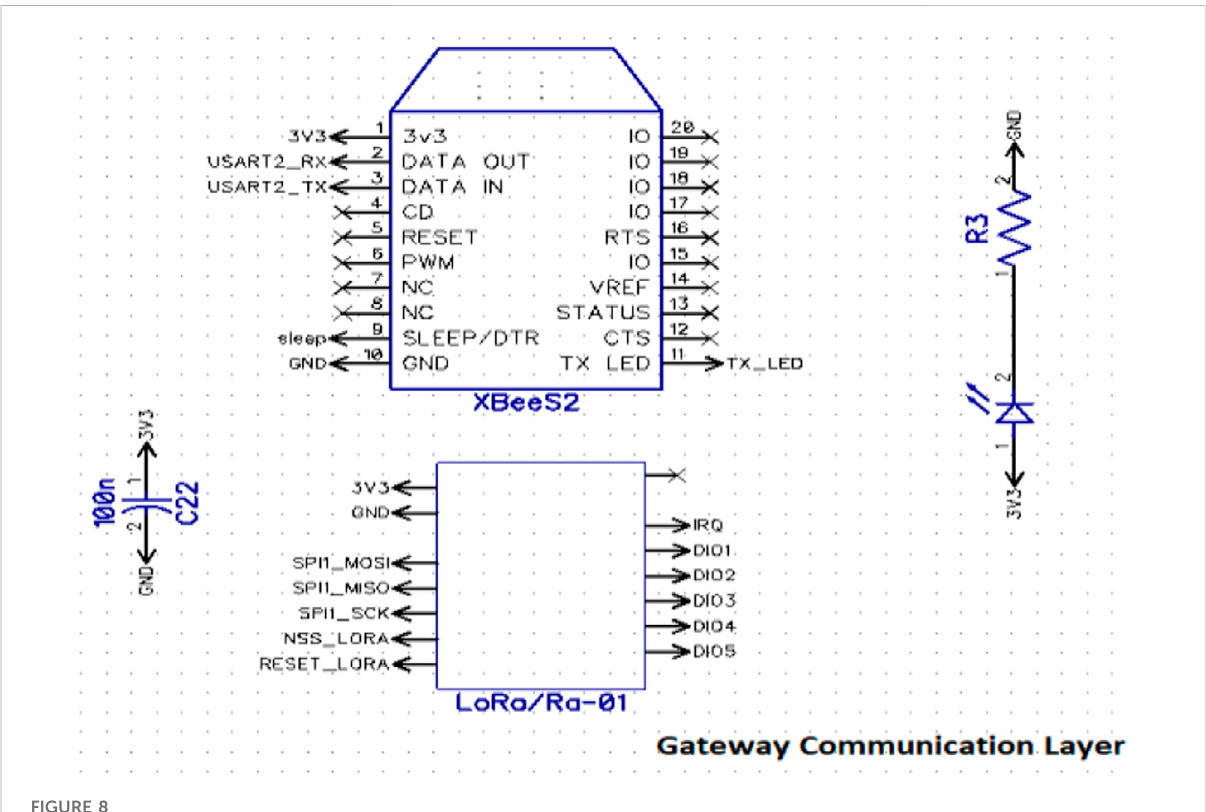
FIGURE 8 Schematic diagram of the gateway ’ s communication layer.